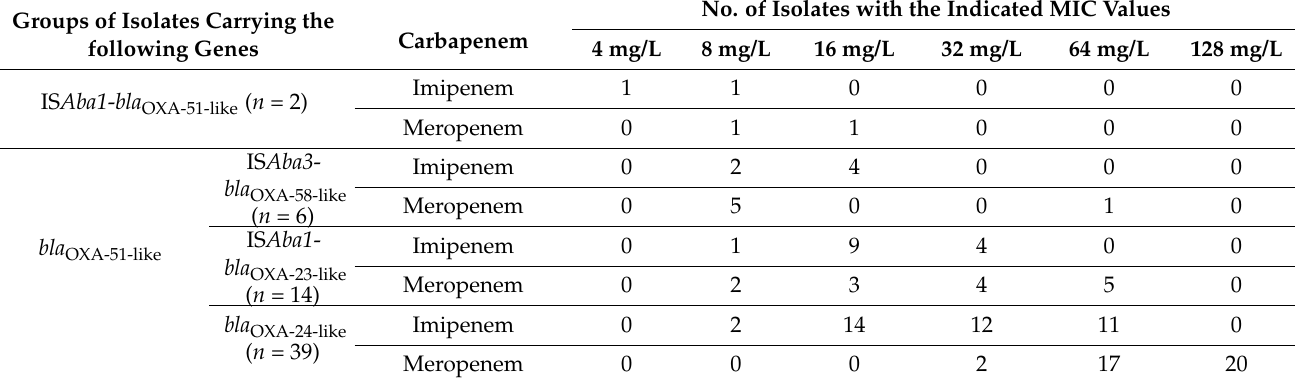
Table 2. The carbapenem minimal inhibitory concentration (MIC) distribution of the bla CHDL -carrying A. baumannii isolates ( n =